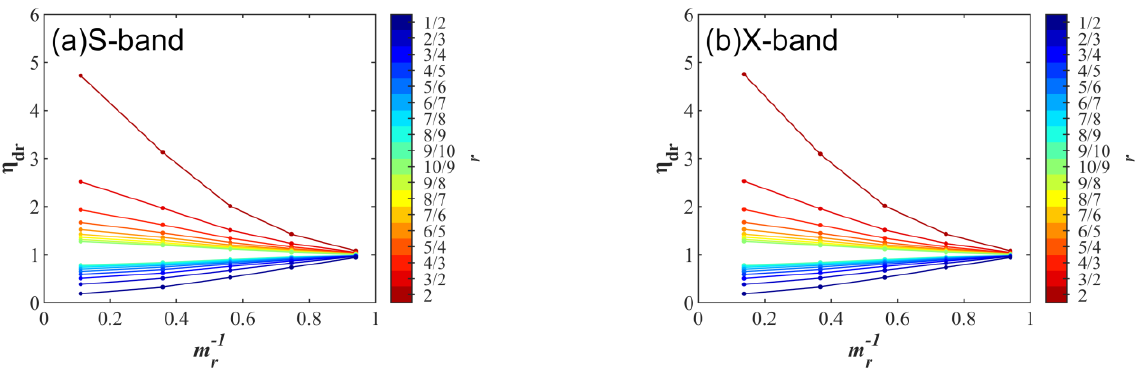
Figure 3. Variation of η dr with m r −1 for a single ellipsoidal water particle with different axial ratios (colors of the lines) when D =1 mm. ( a ) S-band, ( b ) X-band.